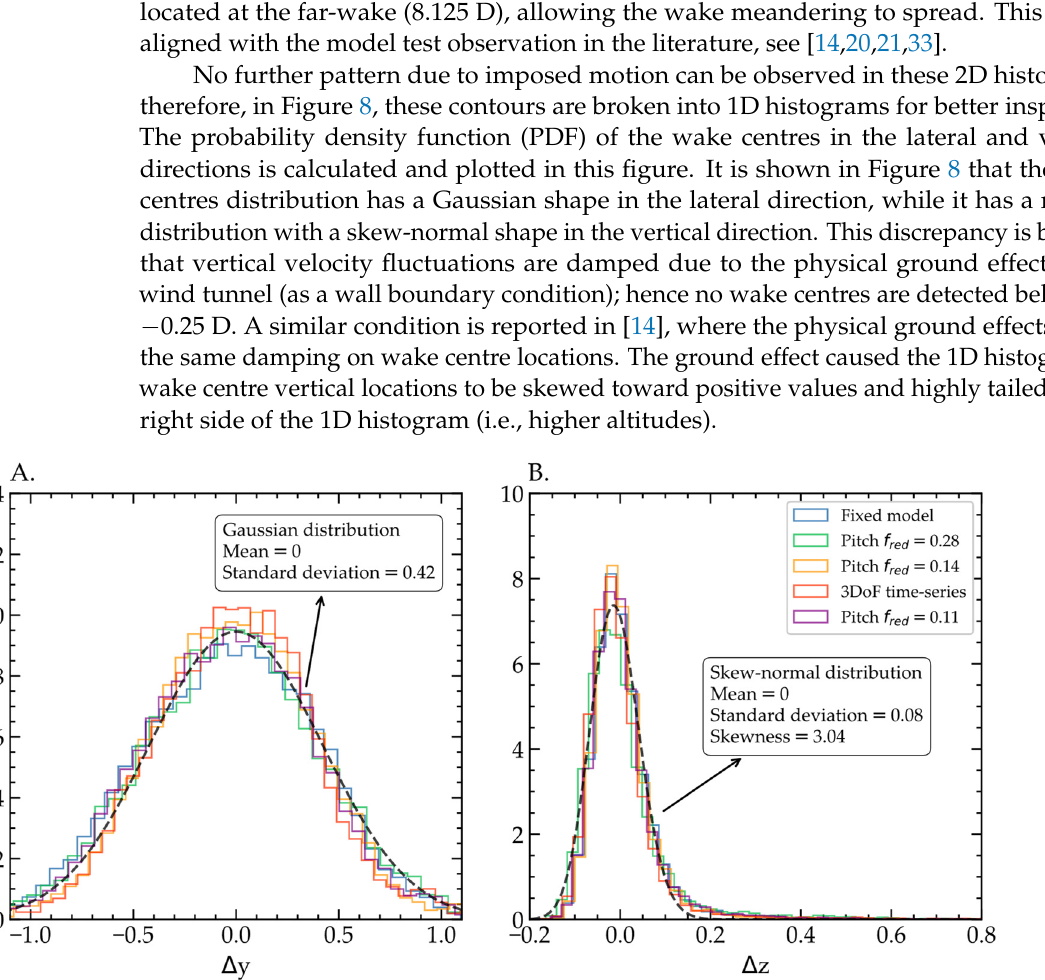
Table 2. Statistics of wake centre time histories.